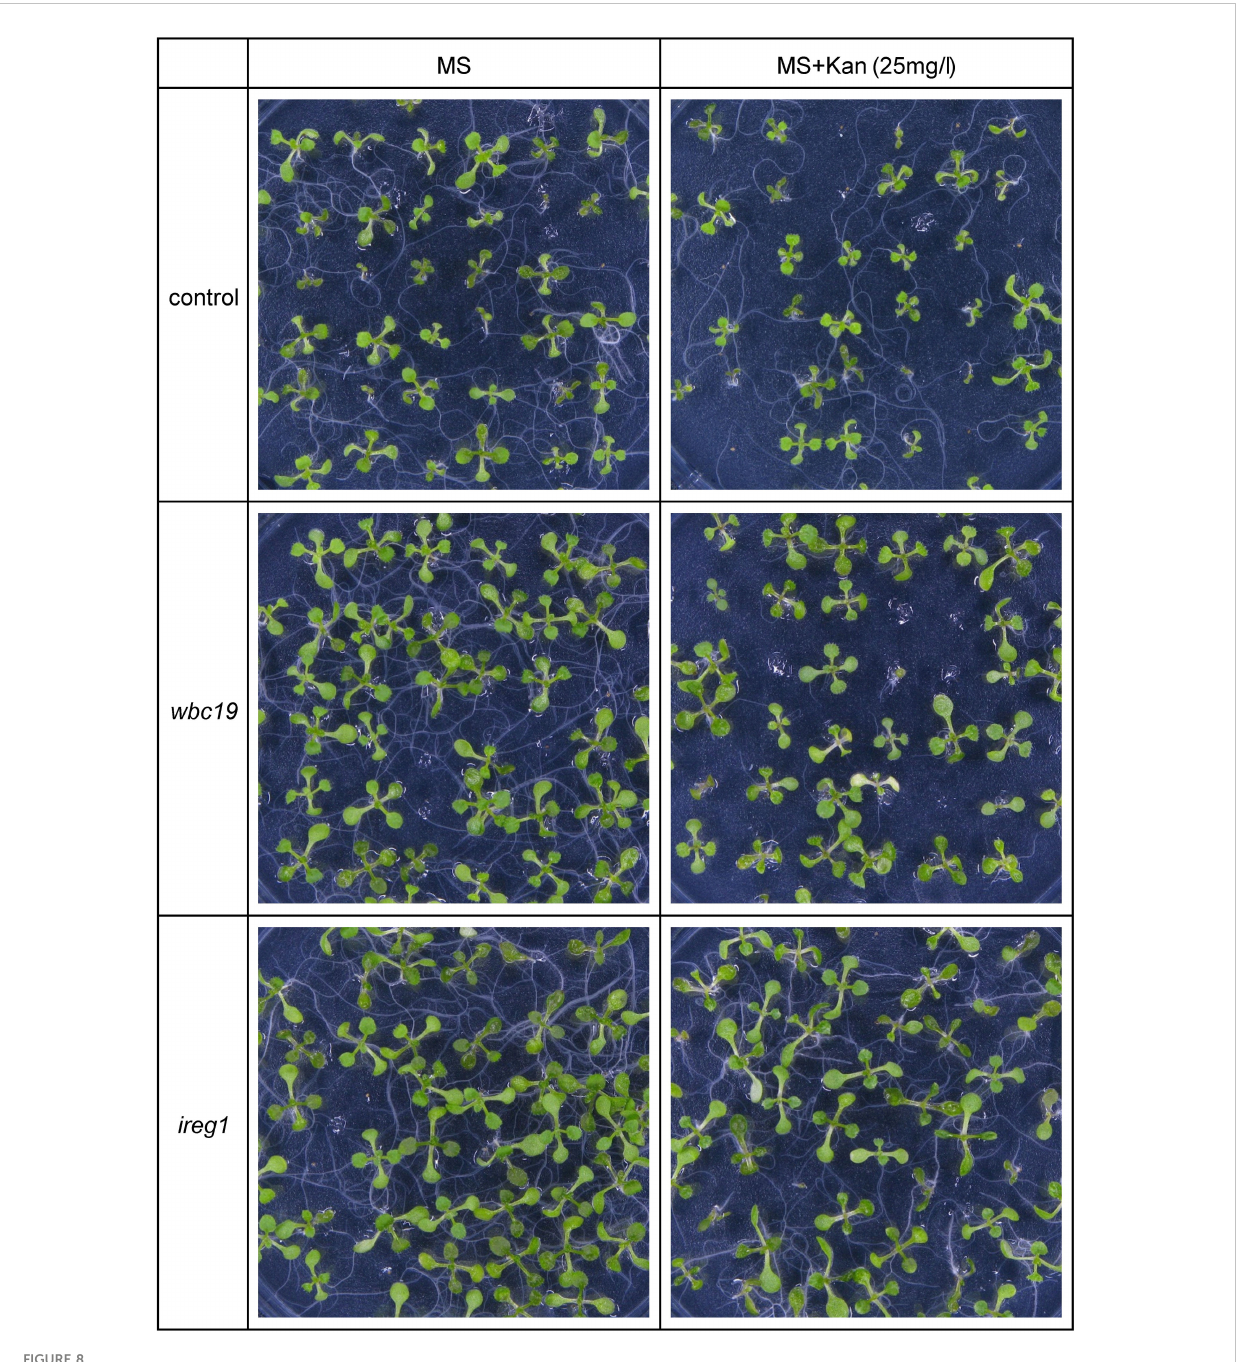
FIGURE 8 Growth of 10-days old control, wbc19 and ireg1 Arabidopsis seedlings on media with 0 or 25 mg/l